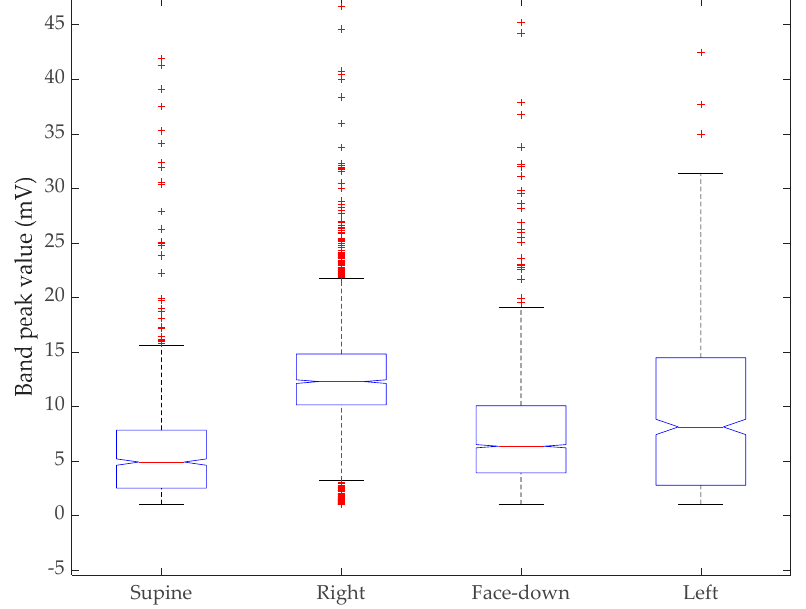
Figure 10. Results of Kruskal–Wallis test. The box plot shows the distribution of peak values of the sensor band versus sleep